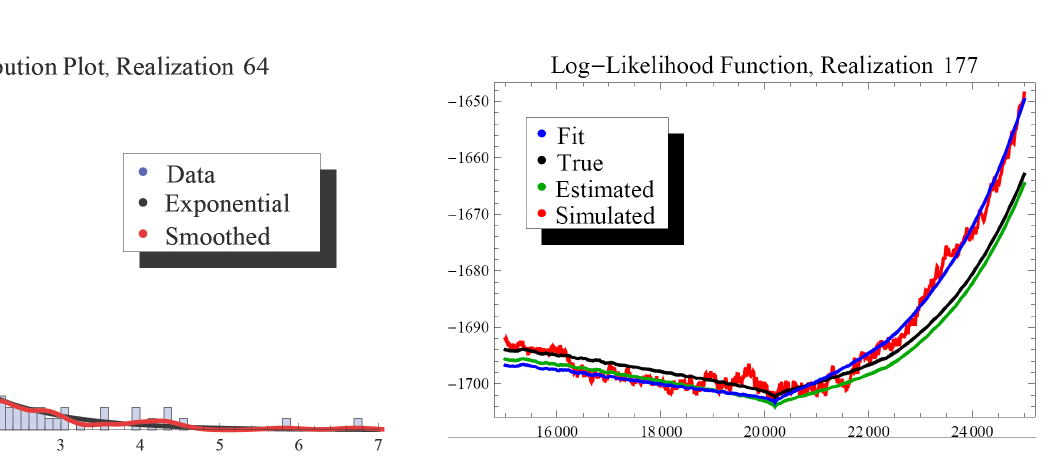
Fig. 16. Log-likelihood functions, as a function of η 1 in km for realization 177, showing hand-fitted as well as estimated and true